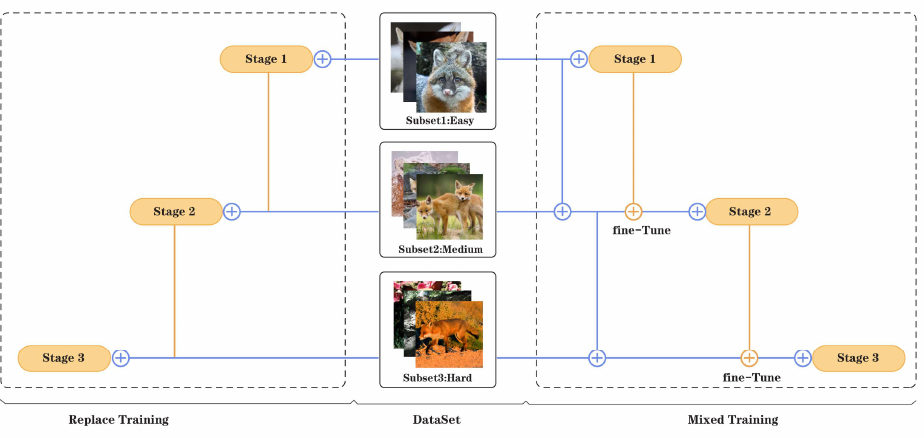
Figure 8. Visualization of a training scheduler based on model convergence. Table 3. Summary of model competence estimation